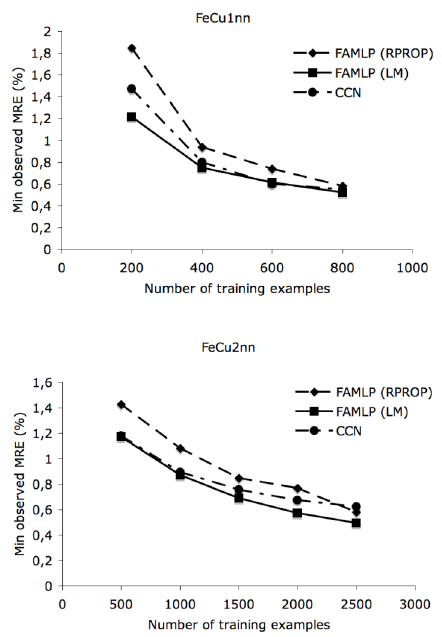
Fig. 12. Minimum MRE observed amongst all training experiments performed.